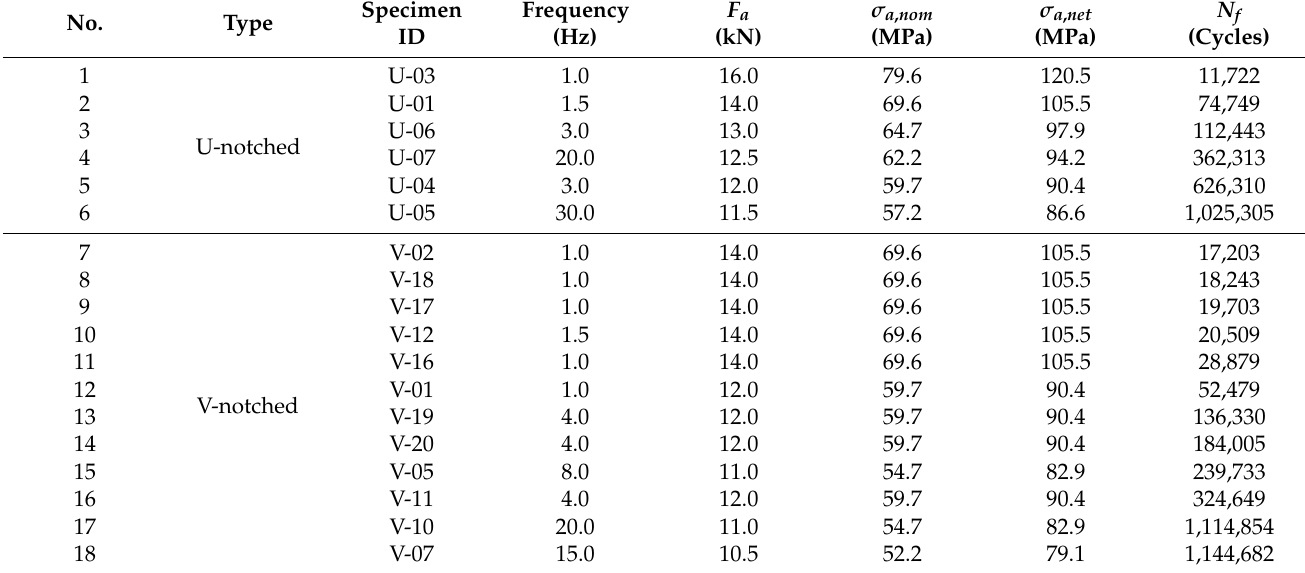
Table 2. Fatigue test results for U- and V-notches with R = − 1. The nominal stress σ nom is calculated at the gripping section ( D = 16 mm) of the specimen, while the net section stress is calculated at the net section ( d = 13 mm). V-notched data were obtained from Albinmousa et al. [37]. Reproduced from [37], with permission from Elsevier, 2020.